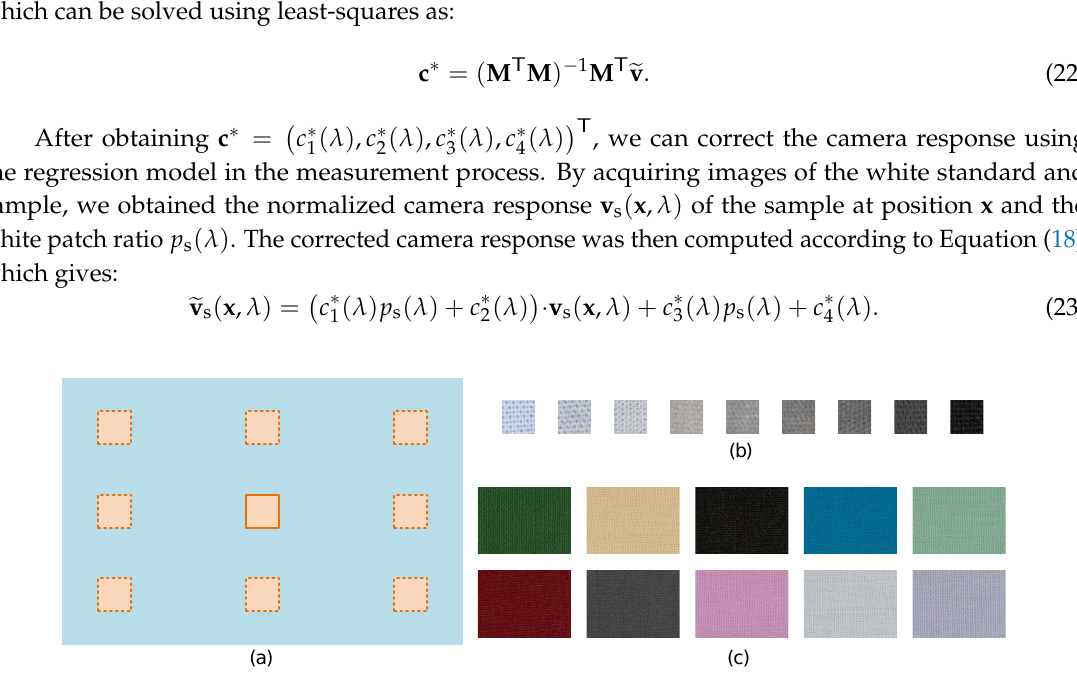
Figure 3. Training data collection. ( a ) Procedure of the measurement. A number of small patches are placed on various samples at different positions, respectively. The camera response of the small patch and the white-patch ratio are acquired in the imaging process. ( b ) Small gray patches of size 0.5 cm × 0.5 cm. The camera response of a small patch is averaged in a 35 × 35 pixel region. ( c ) Uniform background samples of size 10 cm × 8